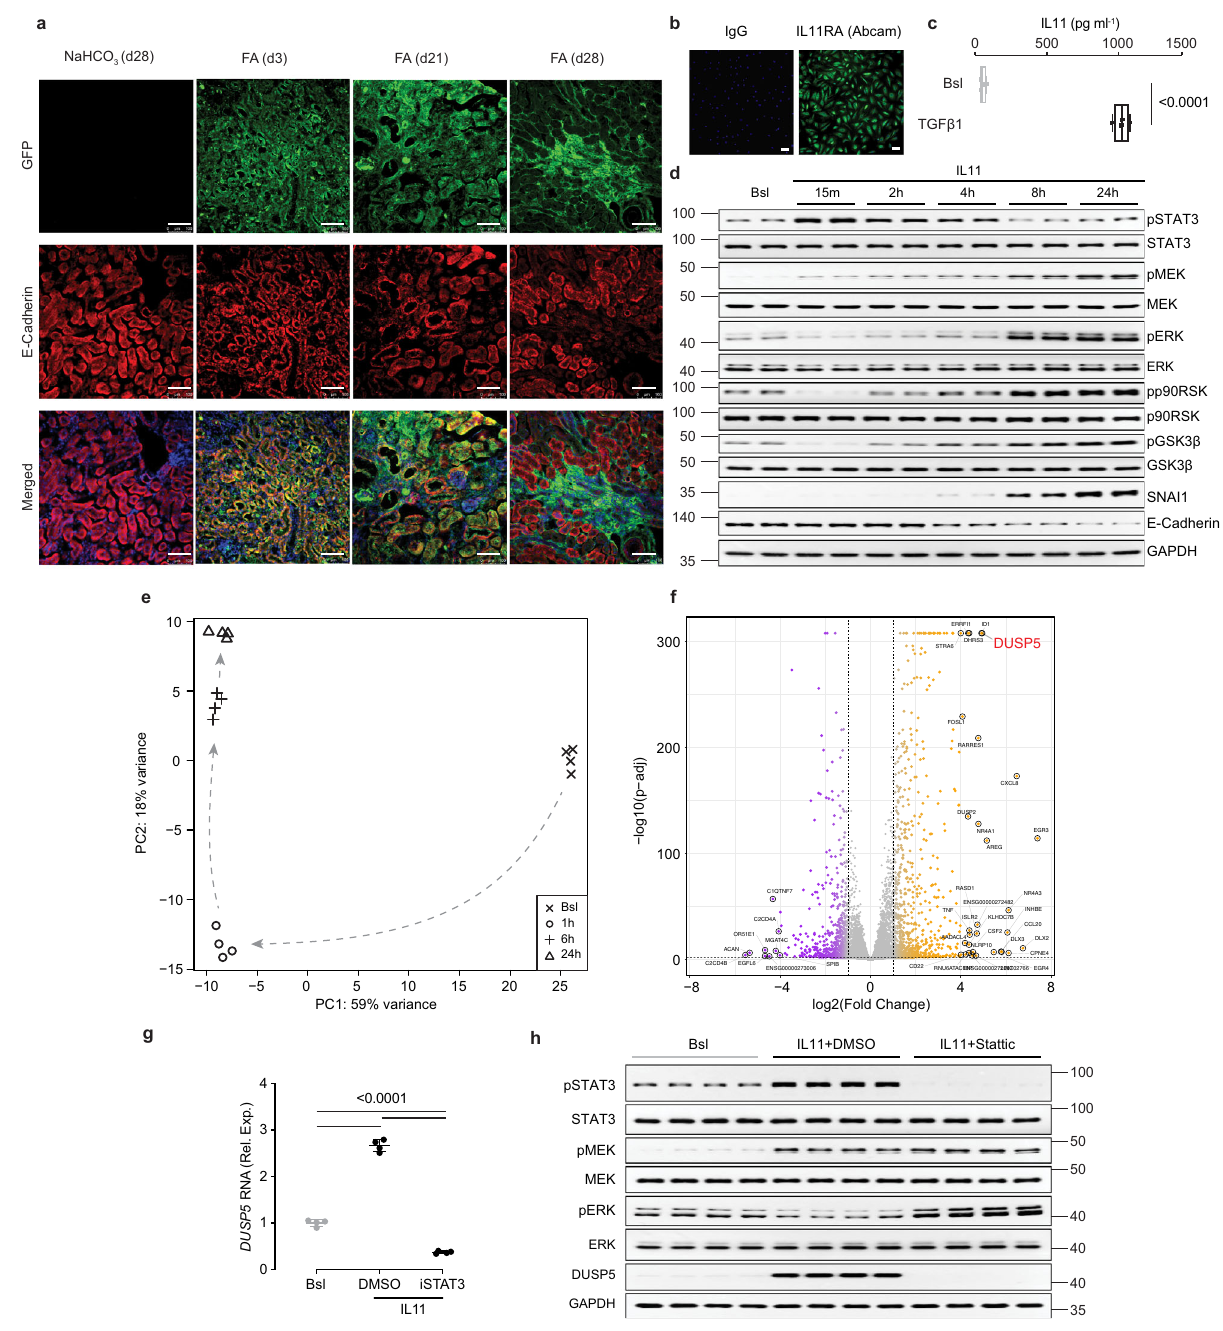
Fig. 1 | Autocrine IL11 activity initiates a pro-in fl ammatory and mesenchymal program in tubular epithelial cells via activation of both STAT3 and ERK. a Representativeimmuno fl uorescence(IF)images(scalebars:100 µ m)ofEGFPand E-Cadherin expression in the kidneys of Il11 EGFP/+ mice following folic acid (FA) injection(kidneyswerecollectedatday3,day21,andday28,representativedataset from n=3/group. b Representative IF images of IL11RA staining of primary human renalTECs(scalebars:100 µ m;representativedatasetfrom n =3/group). c ELISAof IL11 secretion from TGF β 1-stimulated TECs (24h, n =4/group). d Western blots of STAT3, MEK, ERK, p90RSK, and GSK3 β activation and expression levels of SNAI1 and E-Cadherin in IL11-stimulated TECs over a time course (representative dataset from n =4/group). e , f Data for RNA sequencing (RNA-seq) experiments on TEC stimulatedwithIL11for0(Bsl),1,6,and 24h. e Principalcomponentanalysis(PCA) ofRNA-seqacrossthetime-series.PC1andPC2accountfor59%and18%varianceof gene expression, respectively. f Volcano plot displaying the adjusted p -value ( − log10(p-adj)) and fold change (log2(Fold change)) of genes between IL11-